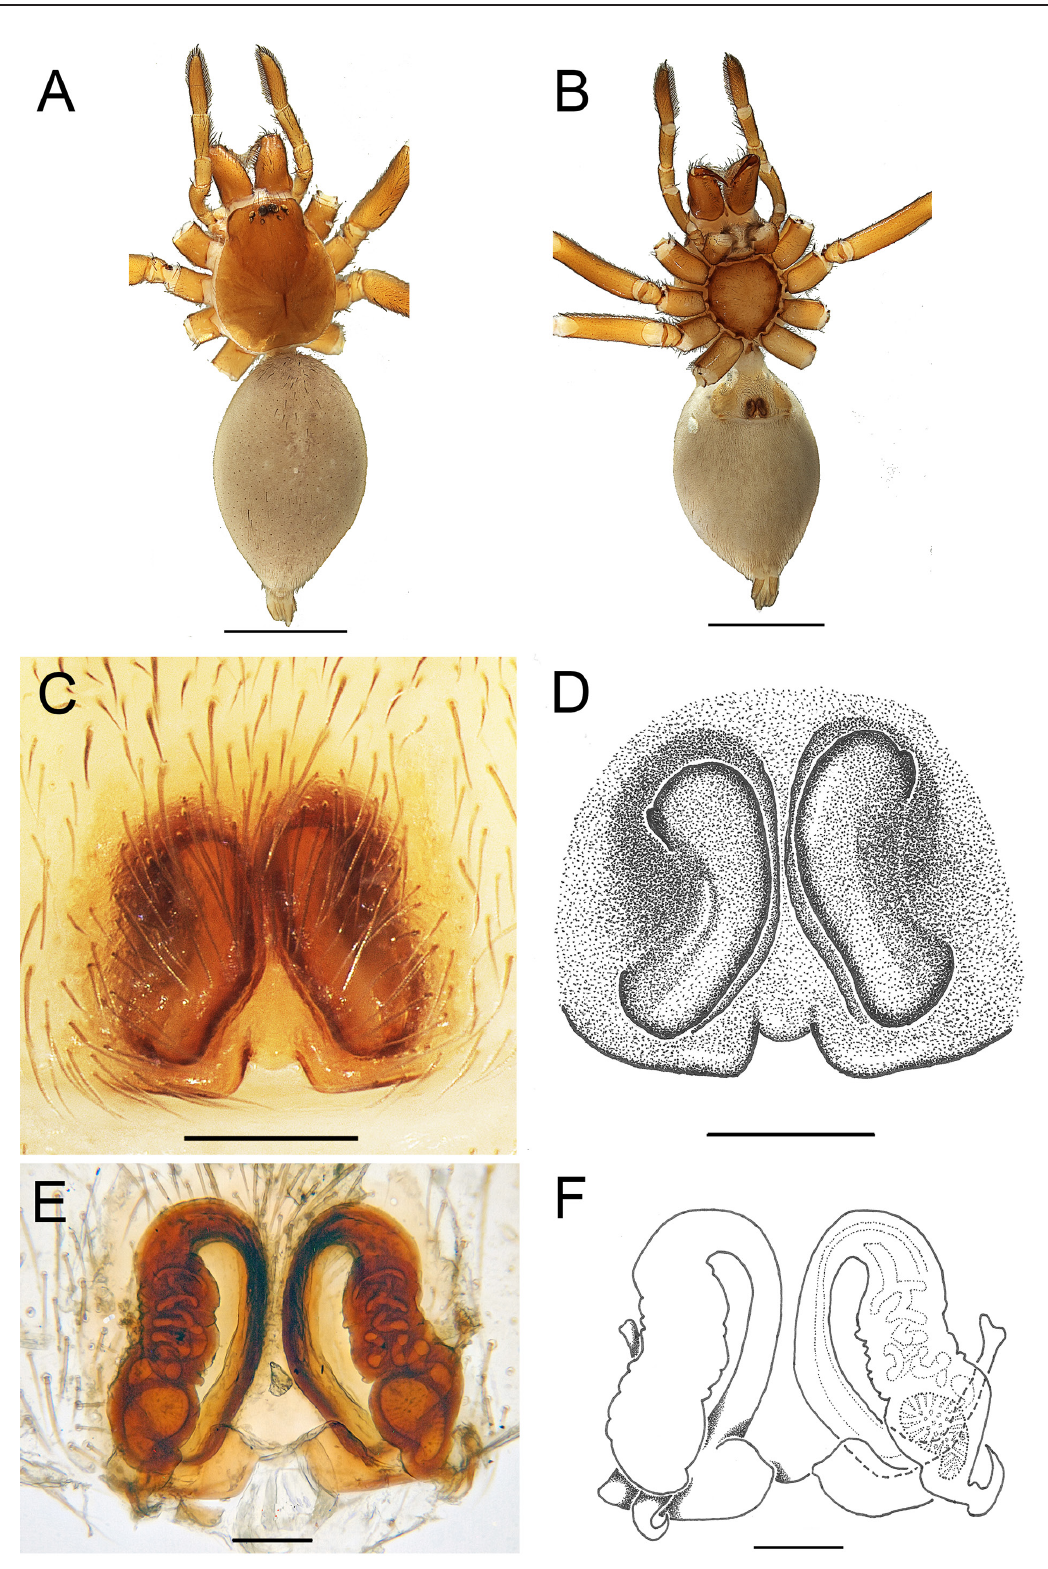
Fig. 22. Andromma divinagraciae sp. nov., ♀, paratype (BE_RMCA_ARA.Ara 246055). A . Habitus, dorsal view. B . Same, ventral view. C–D . Epigyne, ventral view. E–F . Same cleared, dorsal view. Scale bars: A–B = 2 mm; C–D = 0.2 mm; E–F =